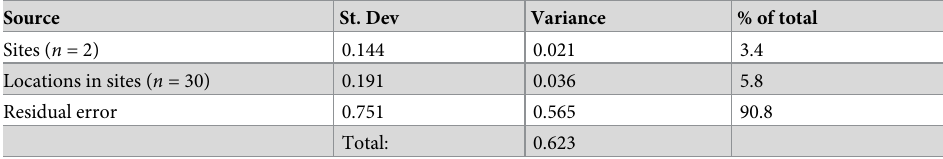
Table 1. Variation in catch rates, partitioned among study sites, trap locations within sites, and residual error from variation among trapping dates across